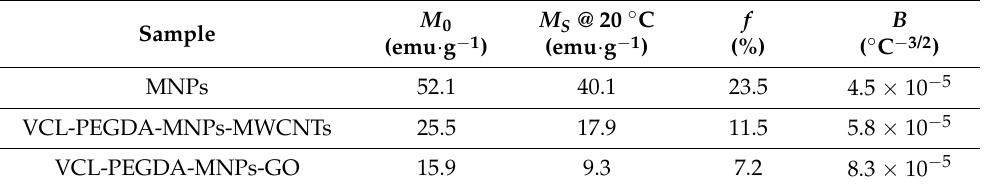
Table 1. Magnetic parameters for the three studied samples: saturation magnetization at T 0 = − 273.15 ◦ C ( M 0 ), saturation magnetization M S at 20 ◦ C, a fraction of the volume of the nanoparticles that remain ferromagnetic (f), and spin-wave constant